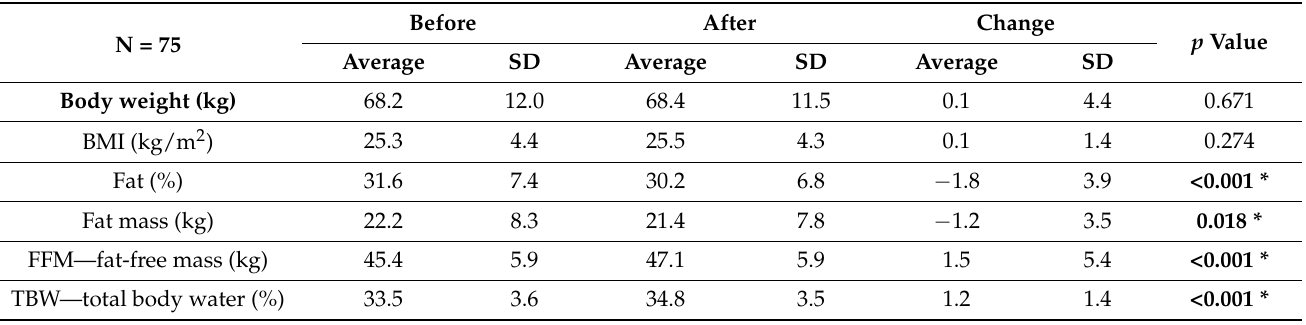
Table 5. Changes in the results of anthropometric parameters of body composition analysis before